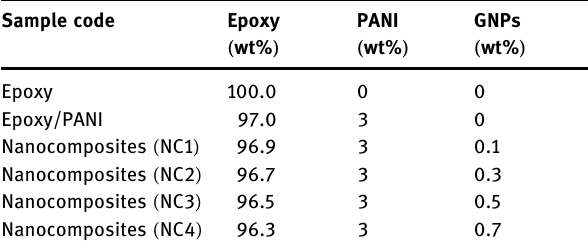
Table 1: Epoxy with various compositions of PANI and GNPs